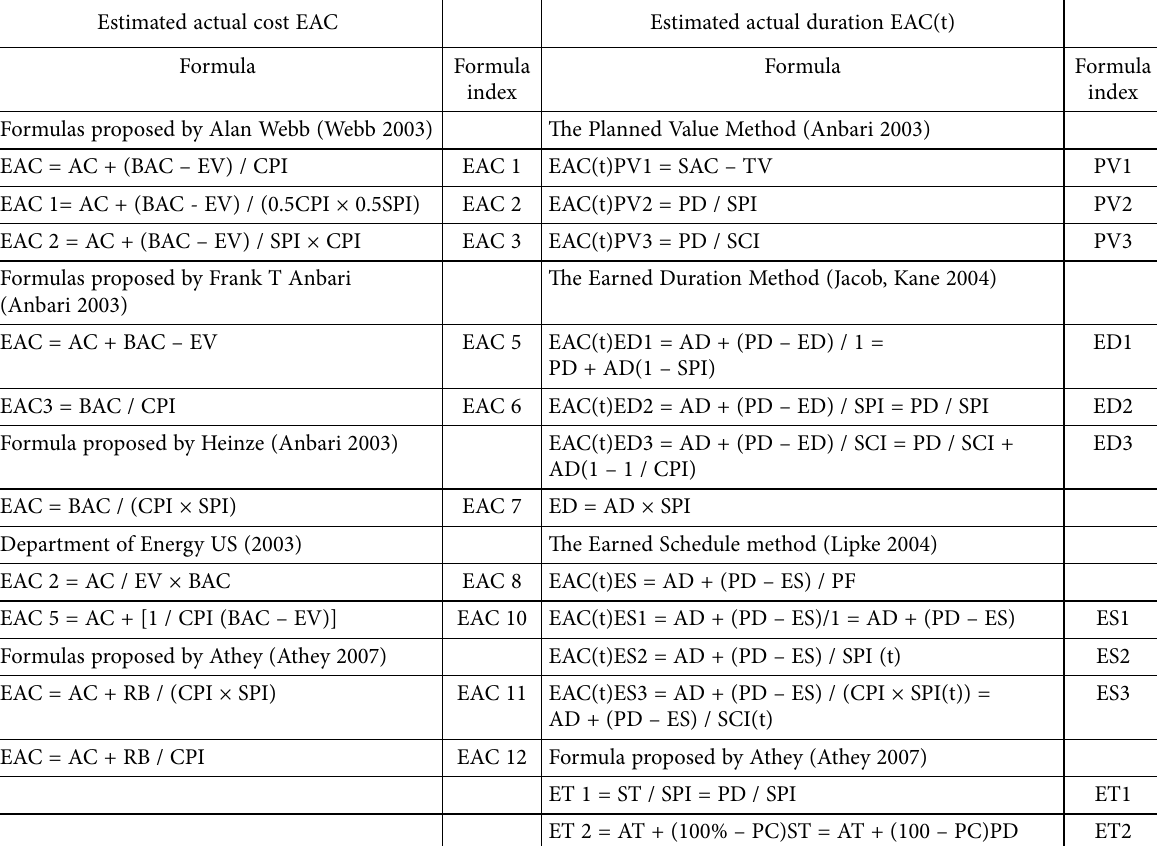
Table 1. List of formulas used to estimate the actual cost EAC and duration EAC(t) (personal